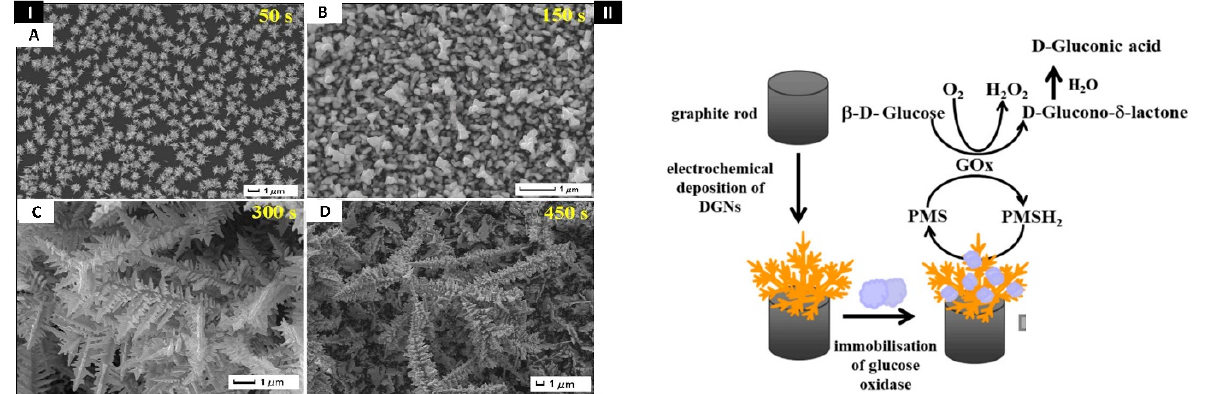
Figure 3. ( I ) Scanning electron microscopy (SEM) images of Ag − AuNDs sensors’ surface at electro- deposition time of ( A ) 50 s, ( B ) 150 s, ( C ) 300 s, and ( D ) 450 s, respectively. Reprinted with permission from [101]. Copyright 2020, Sun et al. ( II ) Pictorial representations show the electrodeposition of dendritic gold nanostructures (DGNs) and immobilization of glucose oxidase (GOx) on a graphite rod (GR) surface for recognition of glucose. Reprinted with permission from [102]. Copyright 2021, Ramanaviciene et al. Table 1. Various metallic nanodendrites-based biosensors for sensing of small molecules. (NR—not reported).